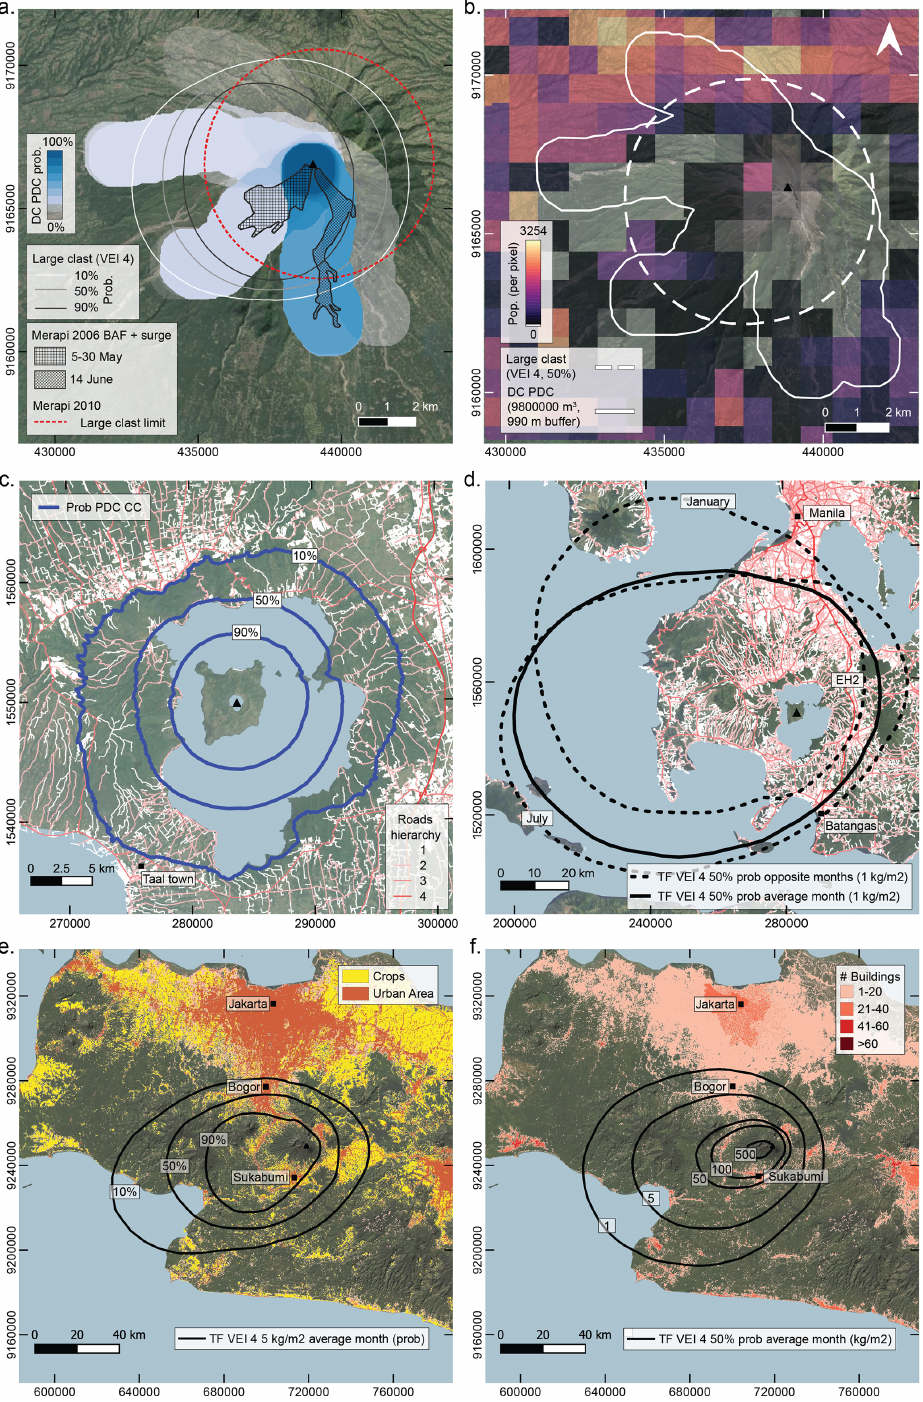
Figure 4. Results of hazard modelling for a VEI 4 scenario for (a) large clasts and dome collapse PDCs (9 . 8 × 10 6 m 3 , 990m buffer) at Merapi, with 2006 dome collapse PDC (Charbonnier and Gertisser, 2008) and 2010 large clast extents (Iguchi et al., 2011) shown by the hashed black areas and dashed red radii, respectively; (b) population exposure data at Merapi (LandScan 2018; Rose et al., 2019) combined with 50% large clast hazard footprint and the outer limit of dome collapse PDC from (a) ; (c) column collapse PDC at Taal overlaying the roads, categorised by hierarchy; (d) tephra fall extent at 50% probability for exceeding 1kgm − 2 for January, July and using whole-year conditions, overlaying roads, categorised by hierarchy (hierarchy legend same as for c ); (e) crops and urban area exposure at Gede–Pangrango combined with tephra fall probability isopachs for an accumulation of 5kgm − 2 for whole-year wind conditions; and (f) number of buildings at Gede–Pangrango combined with tephra fall accumulation isopachs (50% exceedance probability) for whole-year wind conditions. Satellite basemap © Google